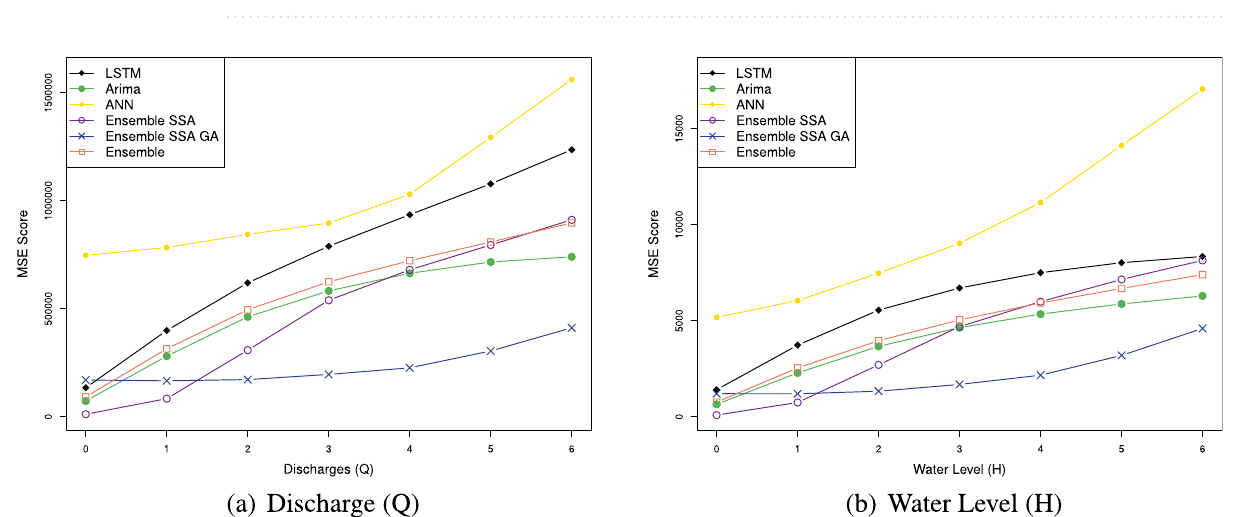
Figure 17. Multi-step-prediction MSE scores of all approaches. The MSE increases when increasing the number of output timesteps. Overall, our proposed method achieves the smallest MSE